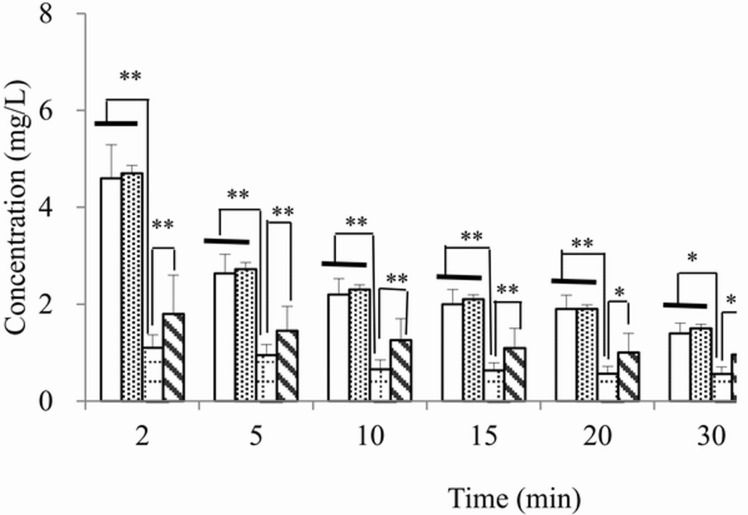
Plasma concentration-time profiles of 1-hydroxymidazolam after intravenous injection in control, HRP-, BCG-stimulated-, and BCG + HRPM-treated rats midazolam (10 mg kg-1).Blood samples were collected at 2, 5, 10, 15, 20, 30, 60, 120, and 240 min after midazolam administration. Plasma midazolam was measured as described in the Materials and Methods section. Data are means ± SD, n = 6, asterisks stars above bars indicate differences between groups.